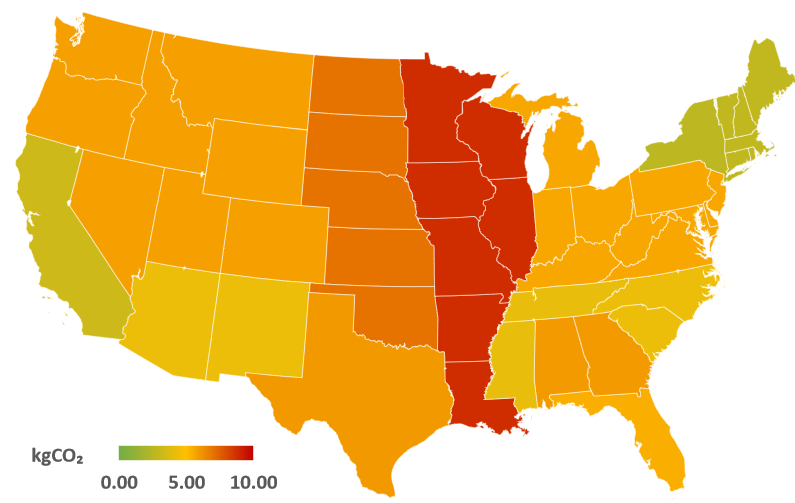
Figure 8. GHG emissions per day due to the charging of one EV in 2019.